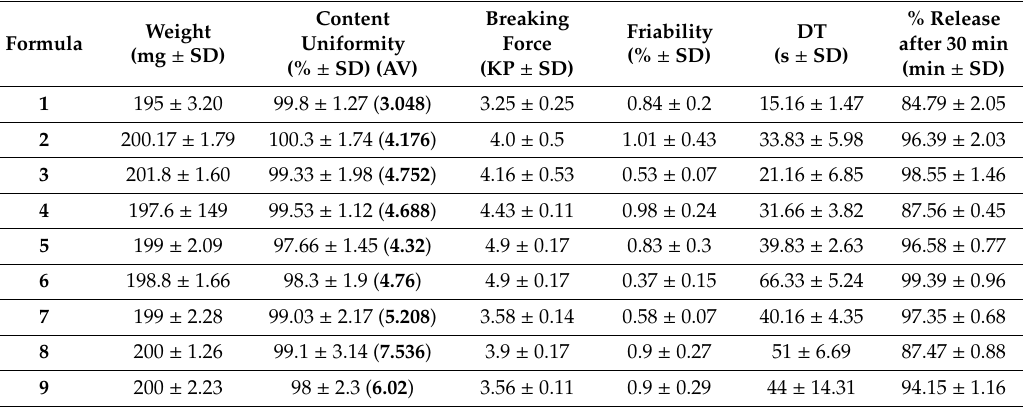
Table 1. Critical quality attributes of sulpiride FDTs formulations (Mean ± SD).